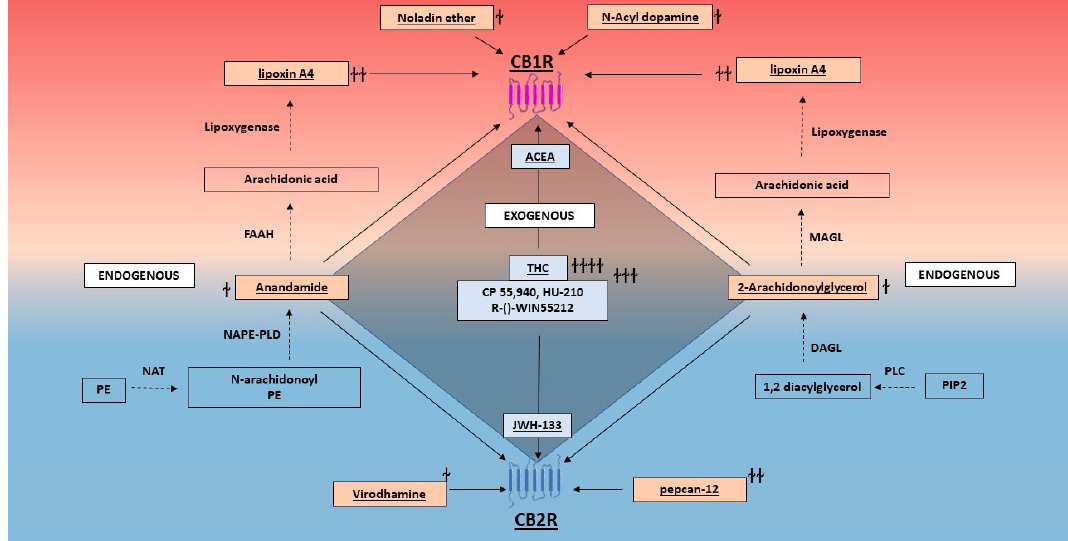
Figure 1. Overview of endogenous and exogenous cannabinoids that activate/modulate CB1R and CB2R. An overview of CB1R activators and modulators are shown in this figure. This includes endogenous ( ɫ , ɫɫ ) , and exogenous ( ɫɫɫ , ɫɫɫɫ ) ligands. Examples of endogenous ligands listed here are the endocannabinoids (2-AG, anandamide, N-acyl dopamine, noladin ether and virodhamine ( ɫ ) ); endogenous positive allosteric modulators (lipoxin A4 and pepcan-12 ( ɫɫ ) ); synthetic exogenous